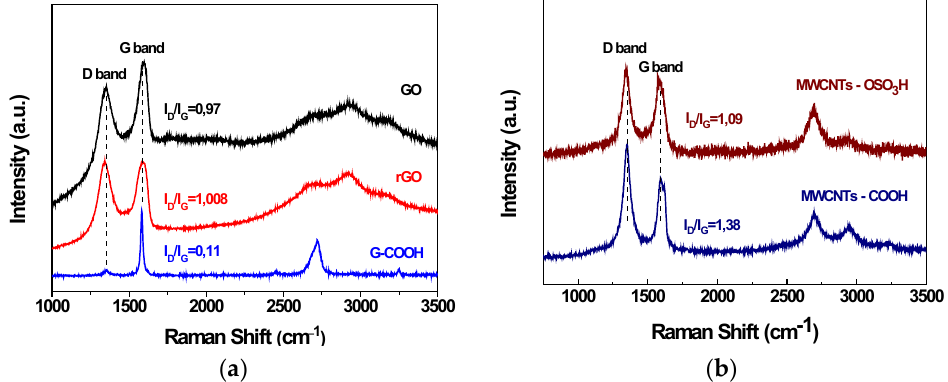
Figure 3. ( a ) Raman spectra of GO, rGO, and G-COOH and ( b ) Raman spectra of MWCNTs-COOH and MWCNTs-OSO 3 H.